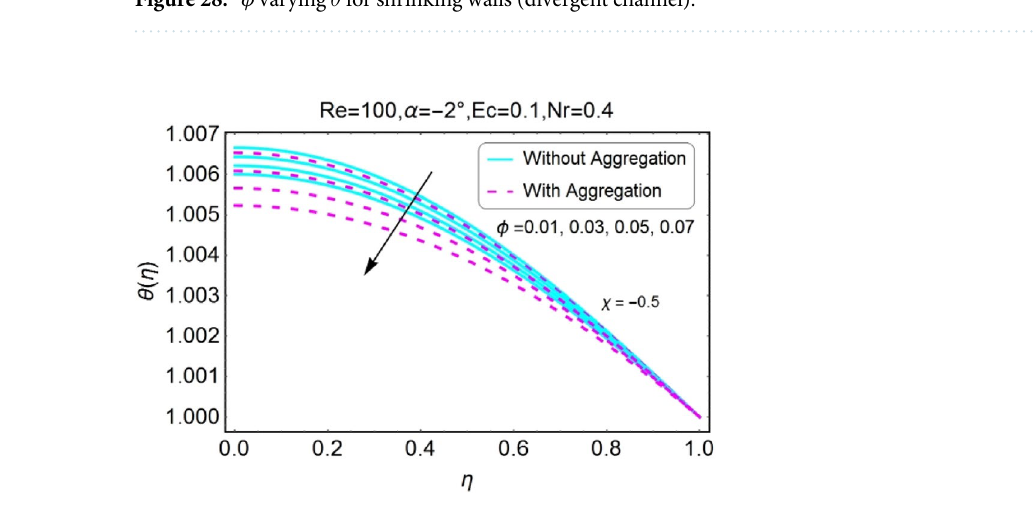
Figure 28. φ varying θ for shrinking walls (divergent channel).